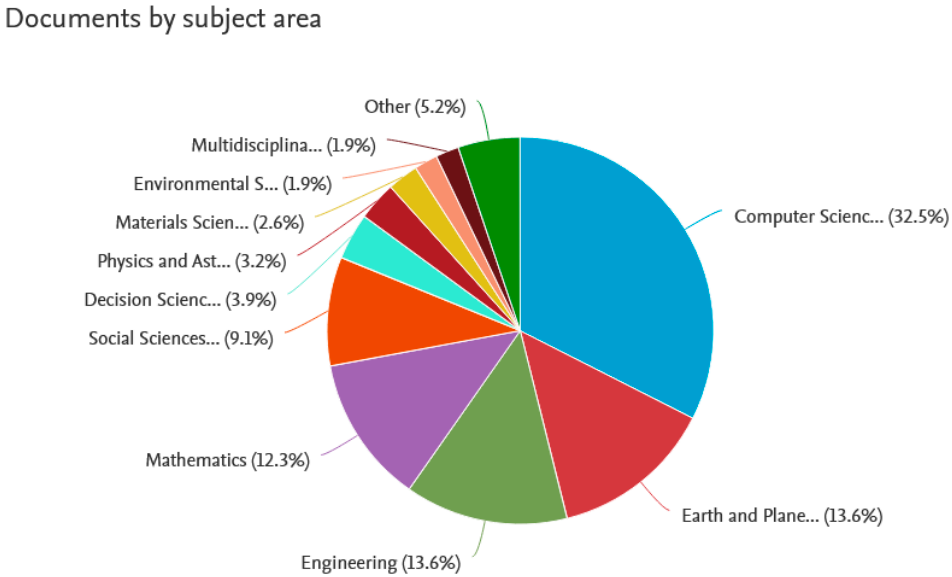
Figure 12. Documents found in Scopus for the “temporal big data” key phrase by subject of publication.